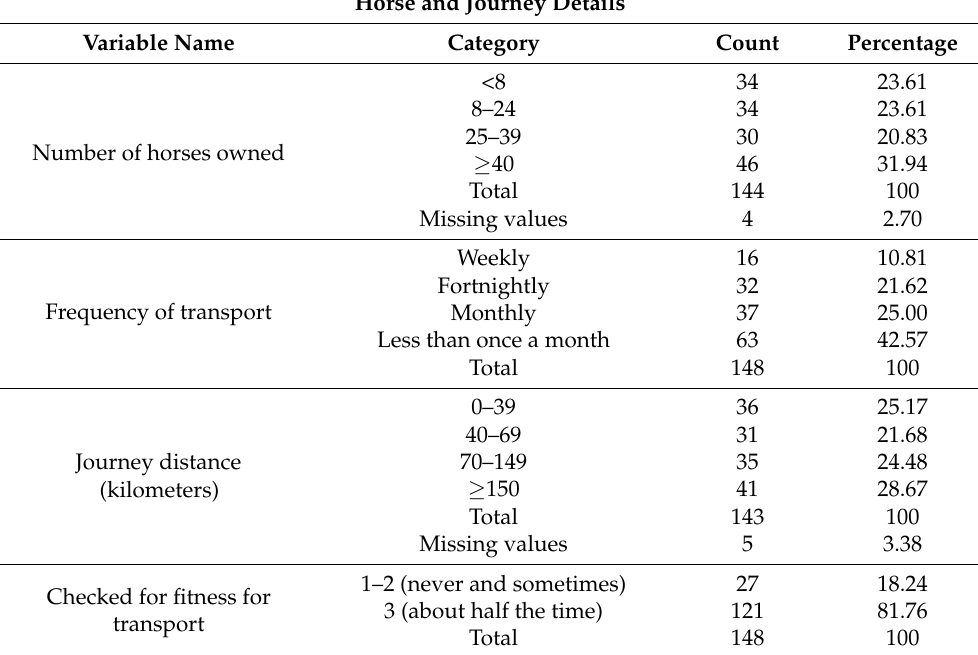
Table 4. Frequency table of the replies ( n = 148) to the horse and journey details in a survey on horse road transport practices, transport-related problem behaviors, horse injuries, and horse handler injuries in